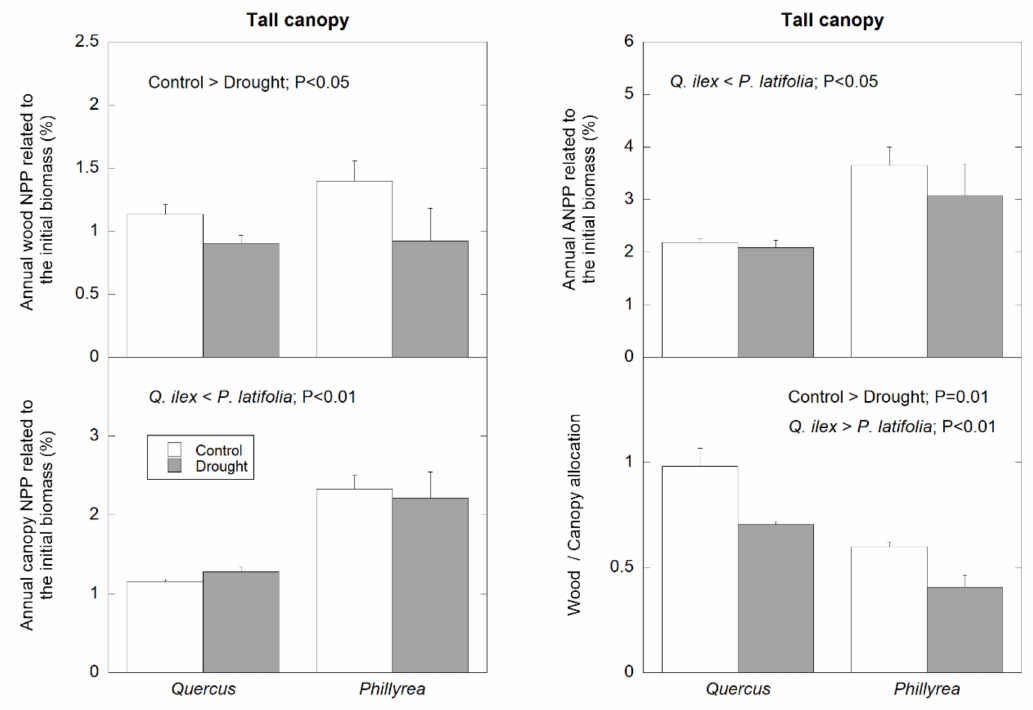
Figure 4. Average percentage of wood NPP, canopy NPP, ANPP, and wood / canopy allocation of the two dominant species in control and plots with partial rainfall exclusion (drought plots), located in the tall canopy stand. Depicted data correspond to the NPP during the overall studied period